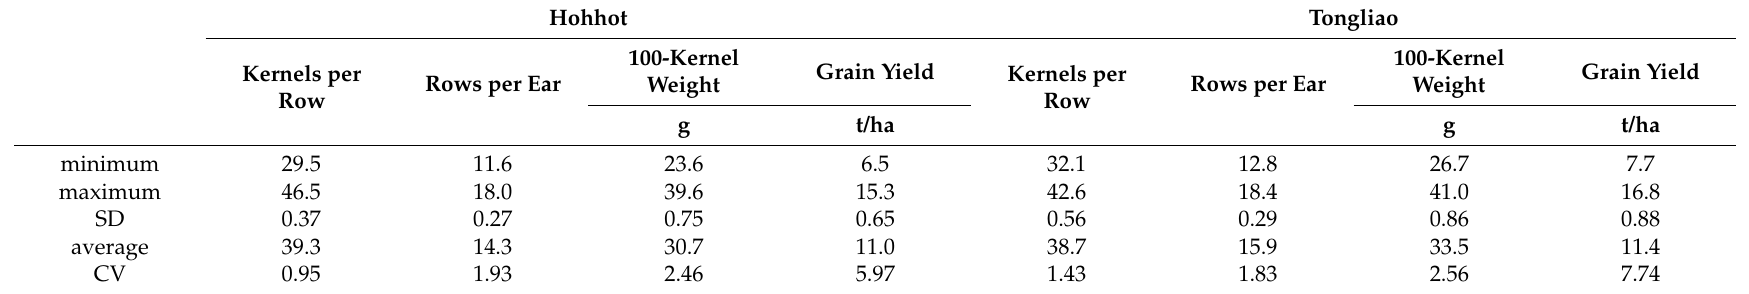
Table 7. Summary of yield-related trait measurements for 64 maize hybrids grown in Hohhot and Tongliao in 2015. Hohhot Tongliao 100-Kernel Grain Yield Kernels per Kernels per Rows per Ear Rows per Weight Row Row